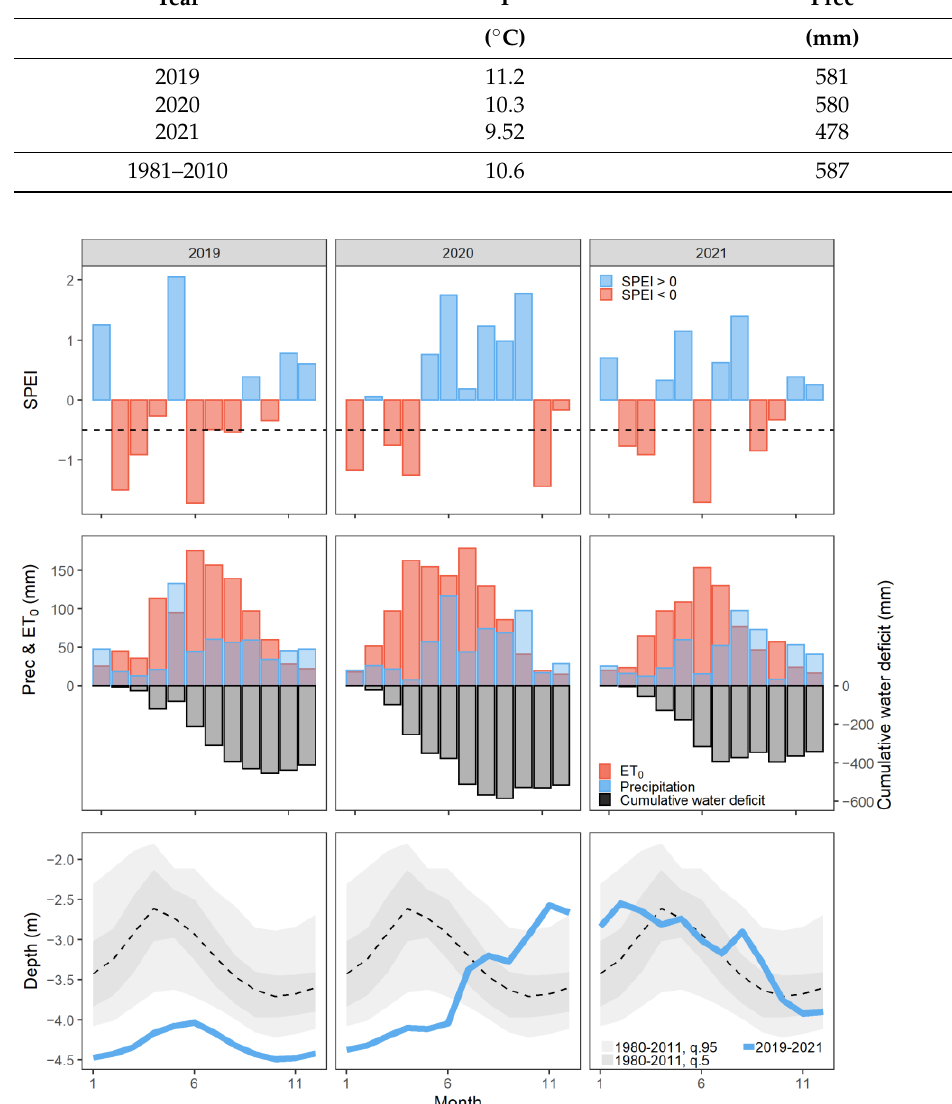
Figure 1. Monthly standardized precipitation-evapotranspiration index (SPEI; upper panels), monthly precipitation (Prec), reference evapotranspiration (ET 0 ), and cumulative water deficit (mid- dle panels), and monthly mean water table depth (Depth; lower panels) during the years 2019–2021. Spring and summer drought accompanied with low depth resulted in harsh environment conditions in 2019. See Figure S1 for long-term trends.